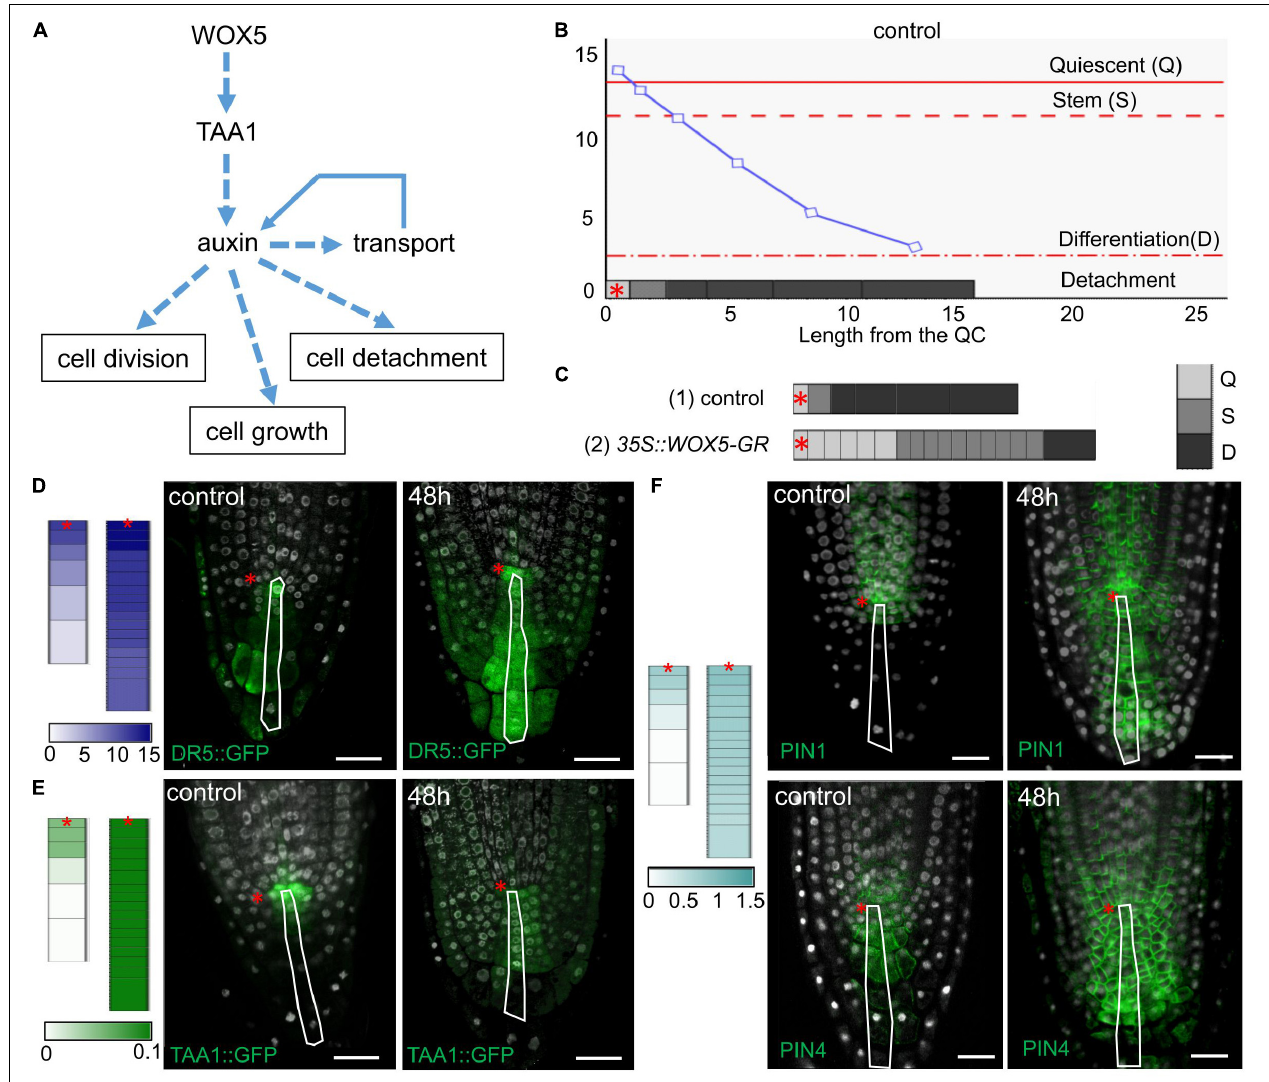
FIGURE 6 | Simulation of cell dynamics in the distal meristem of the 35S:WOX5-GR root tips. (A) The cell dynamics regulations considered in the 1-dimensional model. (B) Simulated auxin concentration in a cell determines its differentiation state. The X -axis denotes the columella length and demonstrates its structure (the QC length in wild type is taken as 1). The gray rectangles on the x- axis display the columella layout with the cells of three following states: Quiescent (Q) – cells can’t grow and divide, Stem (S) – cells can grow and divide, and Differentiation (D) – cells can only grow. The cell states are color-coded in gray scale. The fourth state – detached cells are outside the layout. Y -axis indicates calculated auxin concentration in concentration units ( cu ). The blue curve represents changes in auxin concentration in the layout. Red lines depict the thresholds for state changes depending on auxin concentration. The QC location is marked by the red asterisks. (C) Calculation results for the cell ensembles in control (quasi-balance mode, Supplementary Video 1 ) and DEX-induced 35S:WOX5-GR (broken-balance mode, Supplementary Video 3 ) root tips at 1,500 calculation steps. The colored rectangles display the cell ensemble generated until this calculation step. Gray color intensity reflects the cell states. The QC location is marked by the red asterisks. (D–F) Comparison of calculation results for control ( Supplementary Video 1 ) and DEX-induced 35S:WOX5-GR ( Supplementary Video 3 ) root tips taken at 1,600 calculation steps with the experimental data. Color intensity of the colored rectangles reflects in silico concentration units for TAA1 (green), PINnp (light blue), auxin (navy blue). (D) Auxin concentration levels versus experimental data on auxin response levels (from Supplementary Figure 2 ). (E) TAA1 expression ( Figure 3 ). (F) PINnp expression levels versus immuno-labeling of PIN1 and PIN4 proteins ( Figure 4